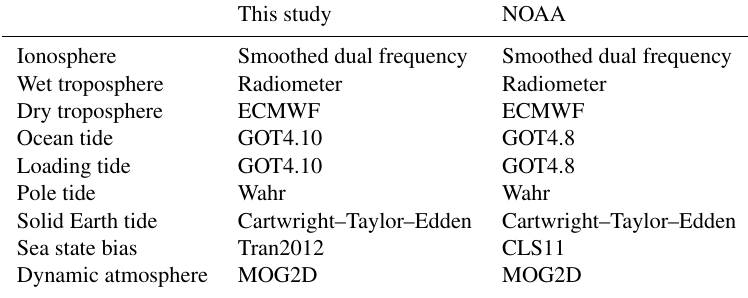
Figure 2. Geographical differences between Jason-1 and Jason-2 sea level estimates averaged over the tandem period. Table 2. List of geophysical corrections applied in this study and for the MSLs of NOAA. This